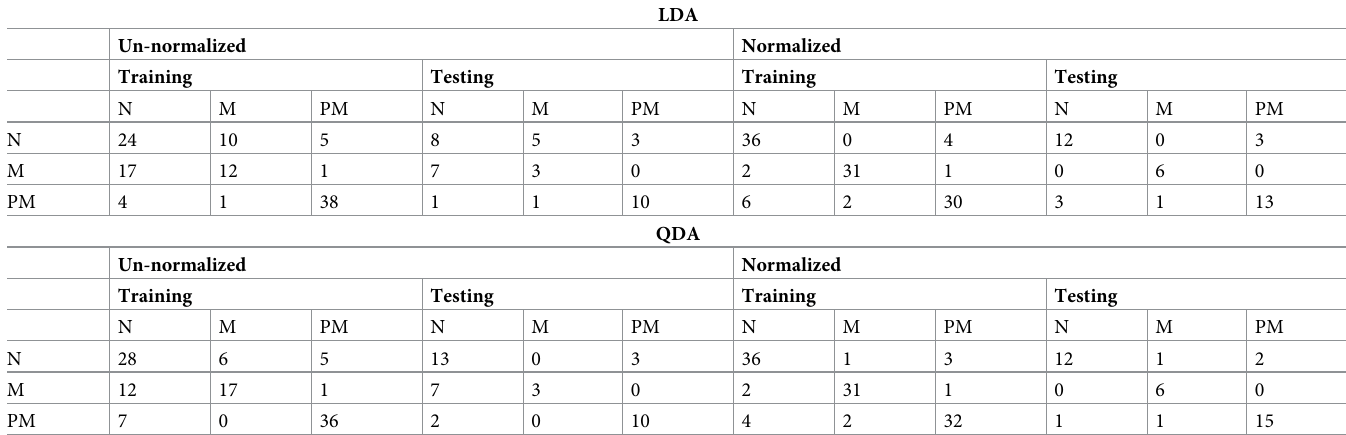
Table 3. Confusion table of LDA and QDA for